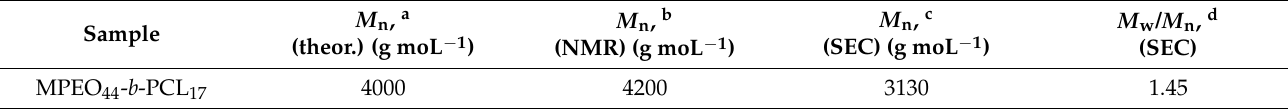
Table 1. Macromolecular characteristics of the MPEO 44 - b -PCL 17 block copolymer.